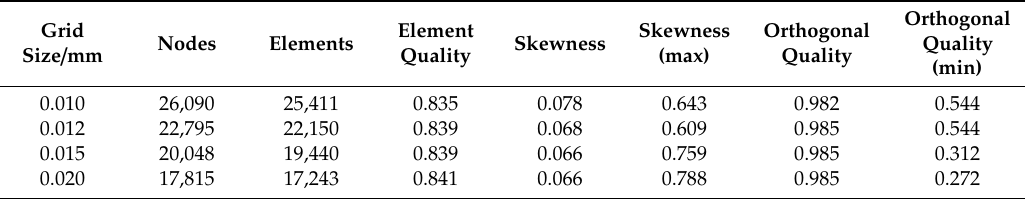
Table 3. Grid parameters.